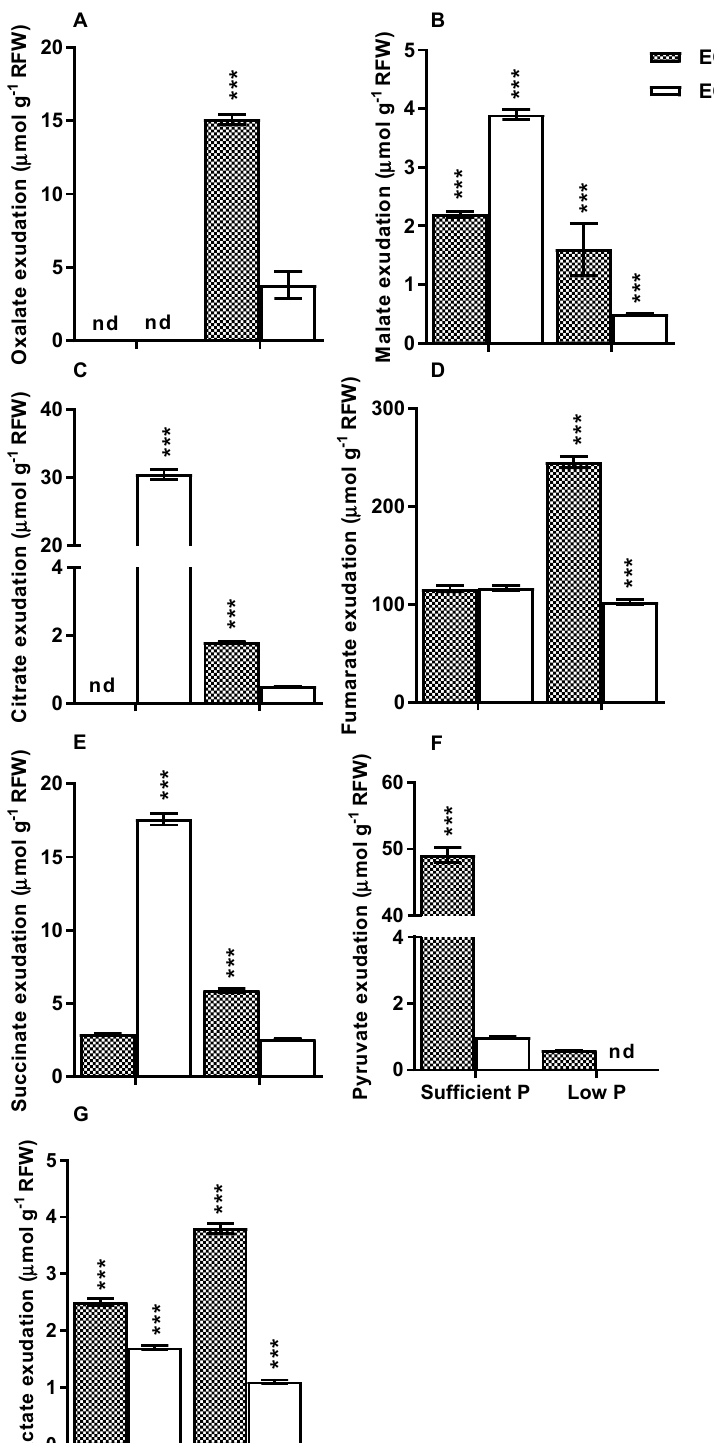
Figure 2. Variation in root exudation of ( A ) oxalate, ( B ) malate, ( C ) citrate, ( D ) fumarate, ( E ) succinate, ( F ) pyruvate and ( G ) lactate in contrasting soybean genotypes grown at sufficient (250 µM) and low (4 µM) P. Data correspond to mean±SE ( n = 9). “nd” denotes peak “not detectable”. RFW: Root fresh weight. *, ** and *** denote significance at 0.05, 0.01 and 0.001 probability levels, respectively.